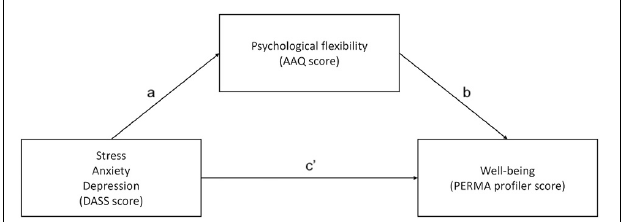
FIGURE 1 | Model depicting the mediation of psychological flexibility on the relationship between negative emotions and well-being. Note: Paths a and b constitute the indirect effect, and path c (cid:48) the direct effect. The sum of all paths represents the total effect exerted on the dependent